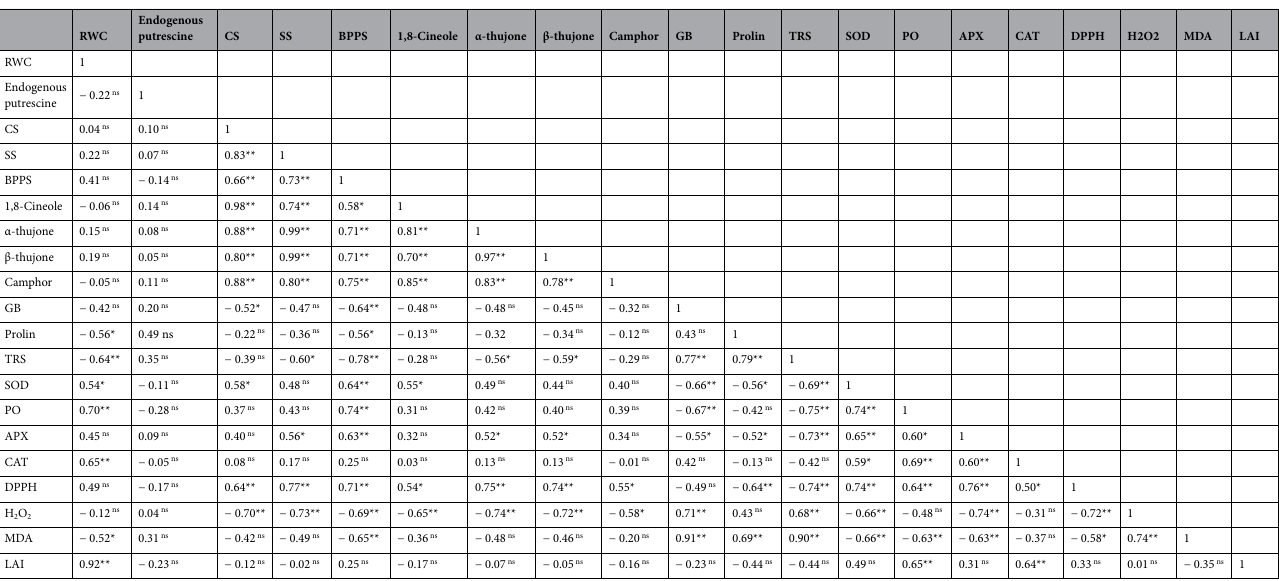
Table 3. Pearson’s correlation coefficients among relative water content (RWC), endogenous putrescine, cineole synthase (CS), sabinene synthase (SS), bornyl diphosphate synthase (BPPS), 1,8-cineole, α-thujone, β-thujone, camphor, glycine betaine (GB), proline, total reducing sugars (TRS), superoxide dismutase activity (SOD), peroxidase activity (PO), ascorbate peroxidase activity (APX), catalase activity (CAT), 2,2-diphenyl- 1-picrylhydrazyl (DPPH), Hydrogen peroxide (H 2 O 2 ), lipid peroxidation (MDA) and leaf area index (LAI) of Salvia officinalis influenced by irrigation regimes and putrescine concentrations. ns non-significant. *α ≤ 0.05. **α ≤